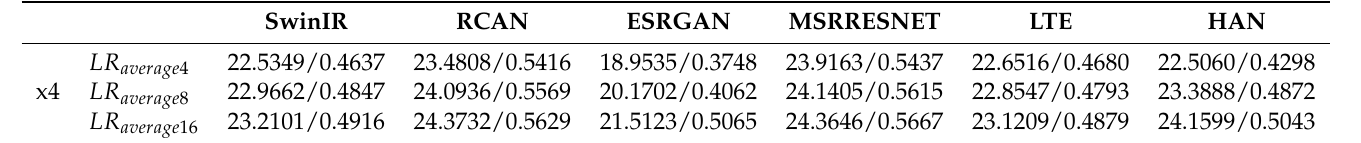
Table 2. Quantitative comparison with conventional SR methods: SwinIR [26], RCAN [9], ESR-